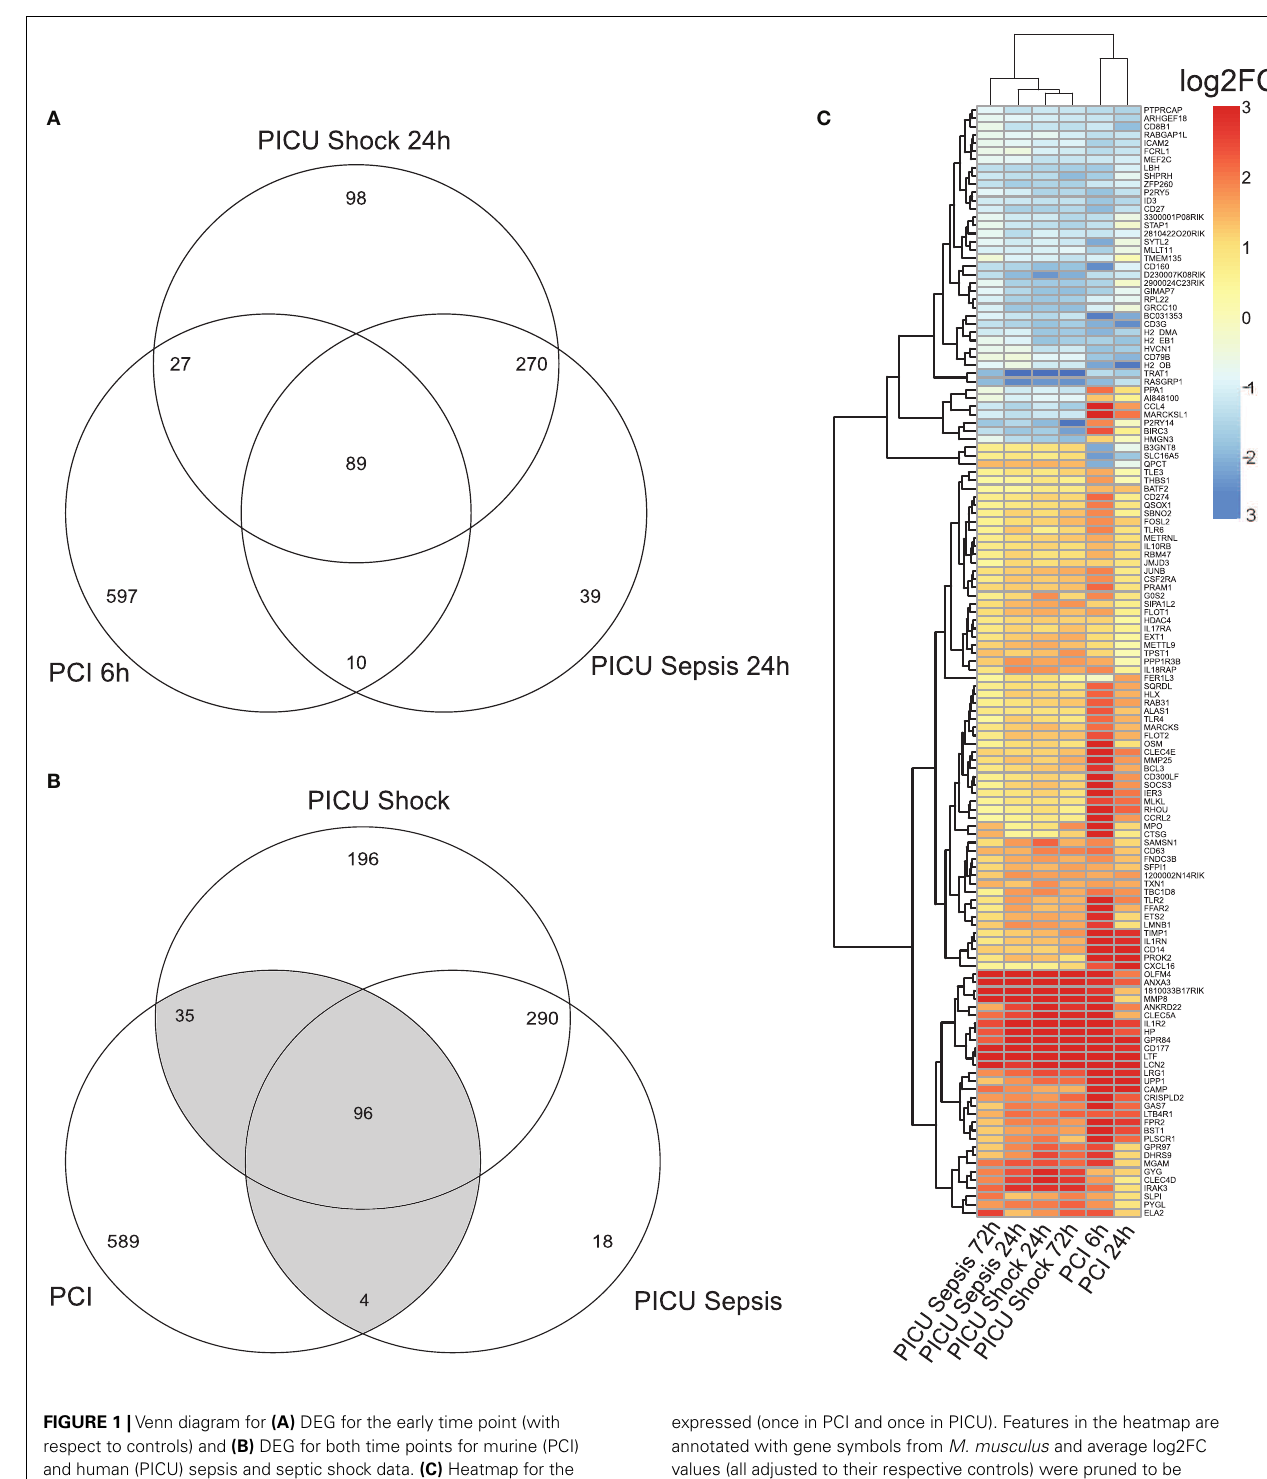
FIGURE 1 | Venn diagram for (A) DEG for the early time point (with respect to controls) and (B) DEG for both time points for murine (PCI) and human (PICU) sepsis and septic shock data. (C) Heatmap for the 135 DEGC, i.e., genes, which are at least two-times differentially